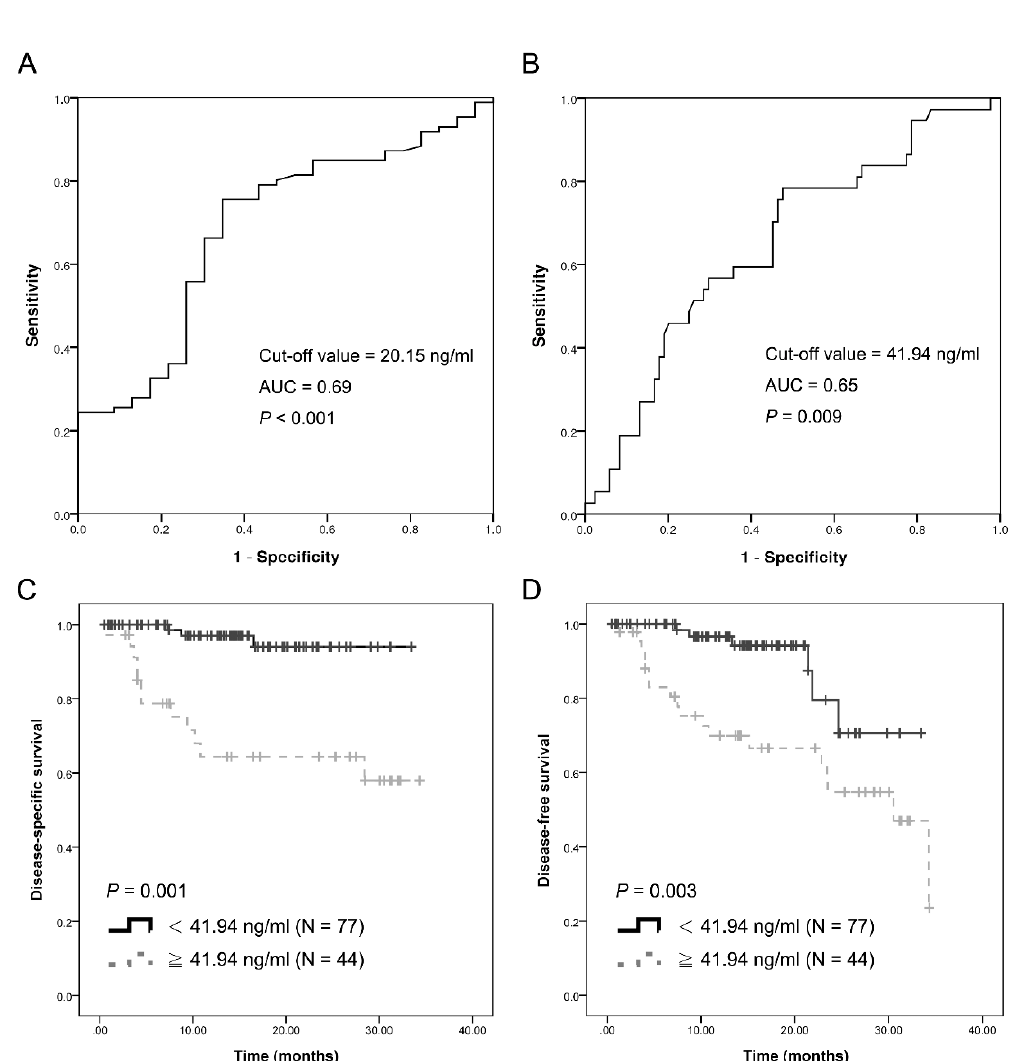
Figure 2. Comparison of cell free DNA (cfDNA) plasma levels. Scatter dot plots with mean ± SD computed by Mann–Whitney test: ( A ) Healthy controls vs. preoperative plasma cfDNA levels in patients with OSCC. ( B ) pre-operative plasma cfDNA levels and different tumor sizes ( C ), Absence or presence of neck lymph node metastasis. ( D ) early and late stage carcinoma and ( E ) lymphovascular invasion status. ( F ) pre-operative and post-operative plasma samples.